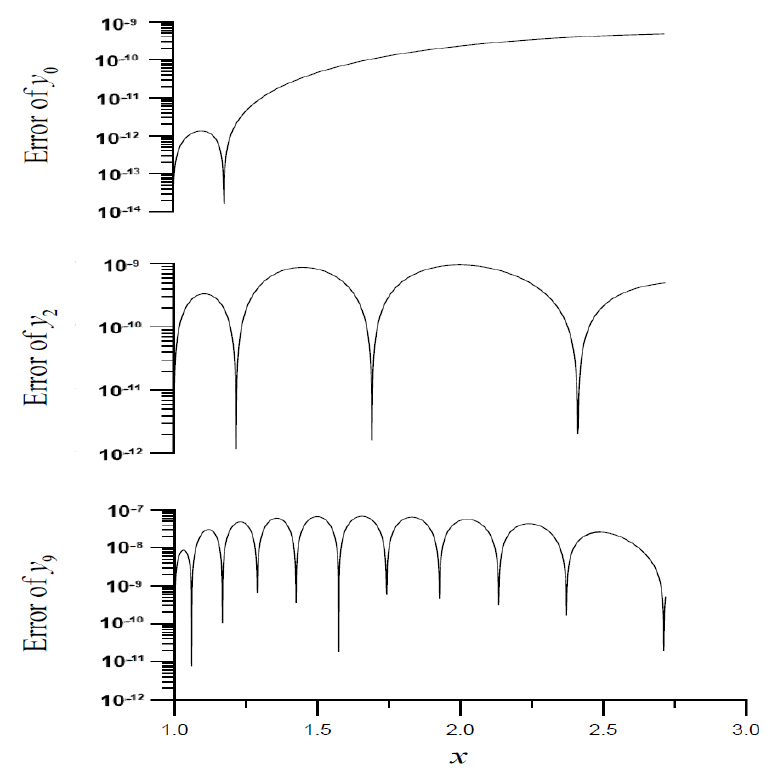
Figure 3. The errors of numerical solutions of the eigenfunctions for Example 1.